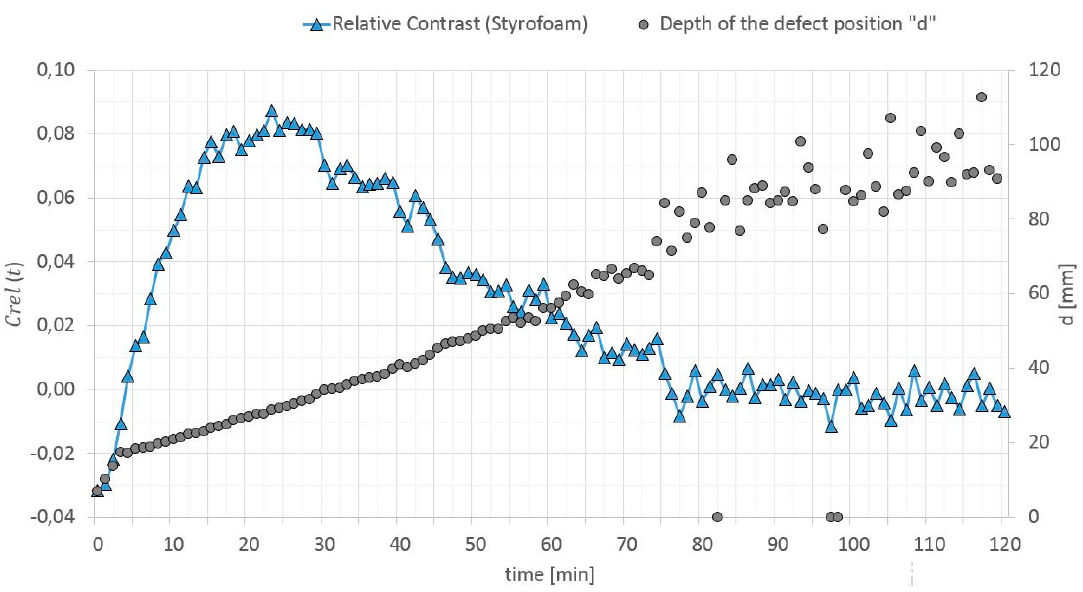
Figure 18. Relative contrast and defect location depth versus time (Styrofoam).